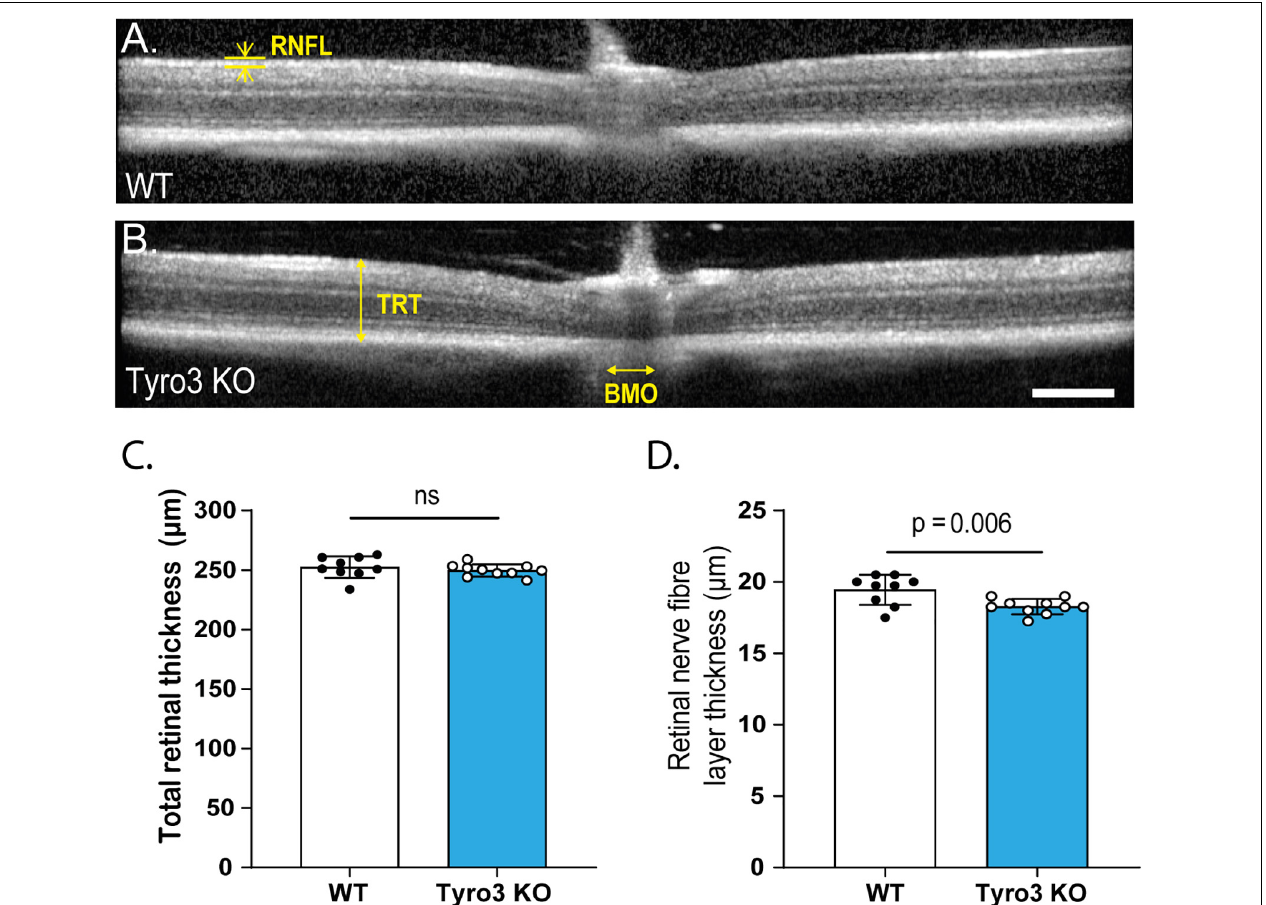
FIGURE 2 | The thickness of the RNFL is reduced in the absence of Tyro3. The retinas of WT and Tyro3 KO mice were imaged in vivo using optical coherence tomography (OCT) ( n = 10 mice/genotype). Representative OCT images from WT mice (A) and Tyro3 KO mice (B) are shown, with key regions identified: retinal nerve fiber layer (RNFL), total retinal thickness (TRT) and Bruch’s membrane opening (BMO). No significant difference was observed in TRT between WT and Tyro3 KO mice (C) . Tyro3 deficient mice displayed a significant reduction in RNFL thickness compared to WT mice ( D ; p = 0.006). Results are presented as mean ± SEM; p -value of mean differences were calculated using a two tailed Student’s t -test. Scale bar = 200 µ m.